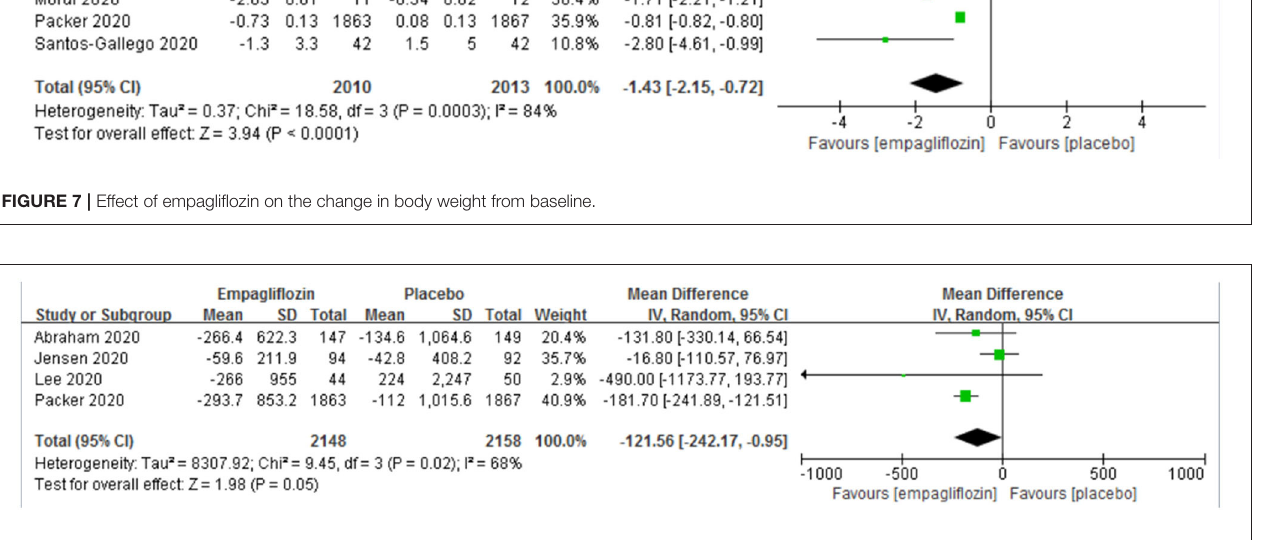
FIGURE 8 | Effect of empagliflozin on the change in NT-proBNP from baseline in HFrEF